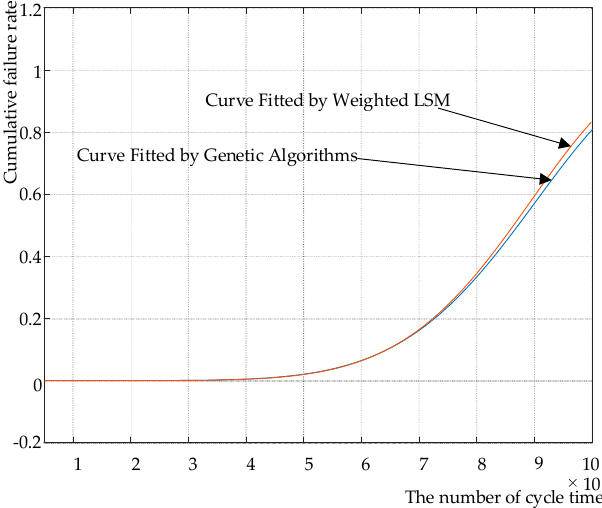
Figure 14. Comparison of Weibull distribution fitted by GA and curves fitted by weighted LSM (least squares method).